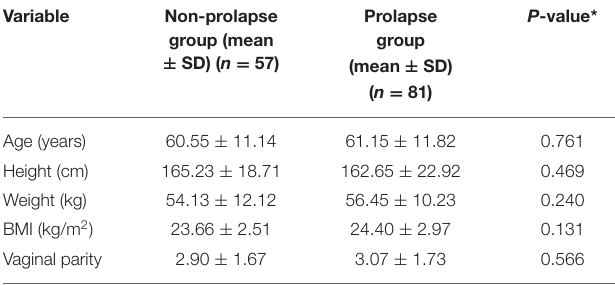
TABLE 1 | Demographic data. TABLE 2 | Measurement of the uterus and vaginal